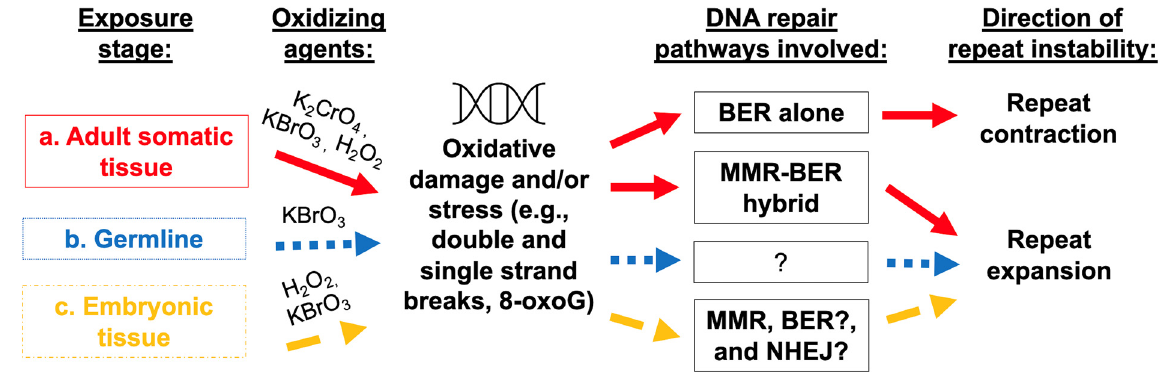
Figure 1. Environmental agents contribute to repeat instability. In adult somatic tissue ( a ), researchers have provided evidence for the role of an MMR-BER hybrid pathway in responding to potassium chromate or potassium bromate exposure, thus, leading to increased oxidative damage and susceptibility to repeat expansion. Additional studies support the role of components of BER and potentially MMR pathways in responding to oxidative damage, such as that induced by exogenous hydrogen peroxide or aging, again resulting in repeat expansion. Of note, when BER pathways alone are involved in responding to oxidative damage, evidence points to repeat contractions rather than expansions. Potassium bromate is shown to affect intergenerational repeat instability in germline cells via oxidative damage. The exact pathways that mediate this form of oxidative damage remain unknown; however, evidence suggests that oxidative damage in the germline ( b ) promotes repeat expansion. Differences in female and male germline instability call for future studies to investigate mechanistic differences in environmentally induced repeat instability in egg and sperm. Both hydrogen peroxide and potassium bromate exposure to embryonic tissue ( c ) is shown to promote repeat expansion. Studies have pointed to the role of MSH2 (component of MMR pathway), as well as suggest additional, potentially hybrid pathways, involving BER and NHEJ in mediating the response to oxidative damage and facilitating repeat expansion. Further research also showed that pluripotent cells are especially susceptible to repeat instability in response to environmental